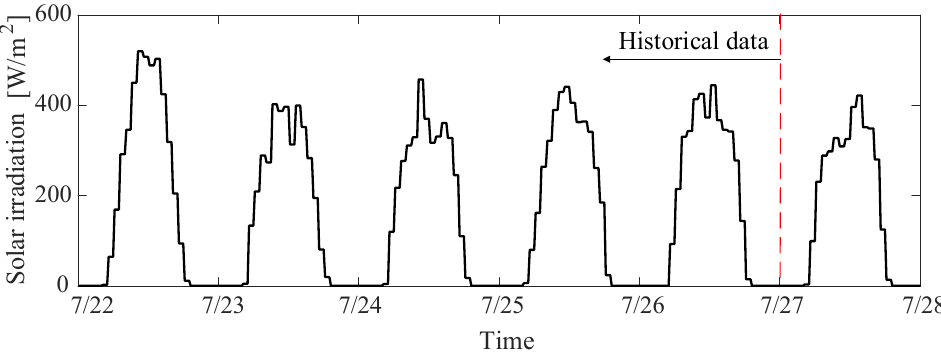
Figure 2. Solar irradiation profiles